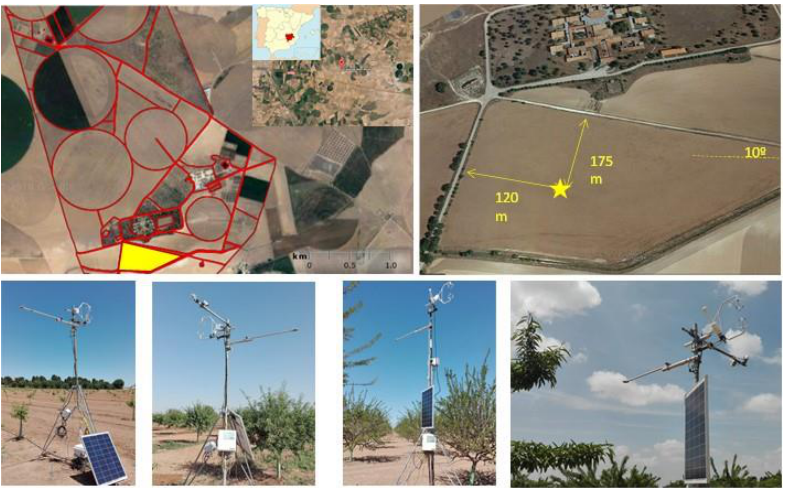
Figure 1. Location and overview of the study field with the flux tower position marked with a yellow star. Pictures of the experimental set-up with the eddy-covariance instruments mounted on a tripod together with the net radiation sensor and thermal infrared radiometers, from 2016 to 2019 ( left to right